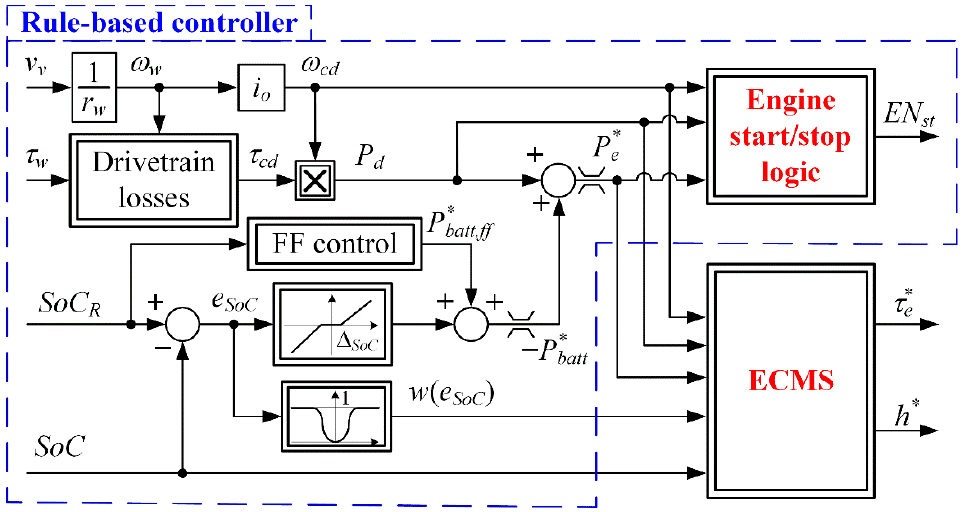
Figure 12. Block diagram of combined RB controller and ECMS optimization.